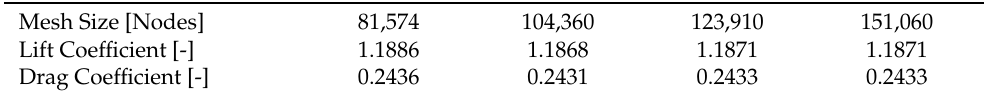
Table 1. Mesh independence study